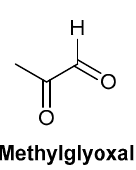
Figure 9. Chemical structure of methylglyoxal, the main antibacterial component of Manuka honey.